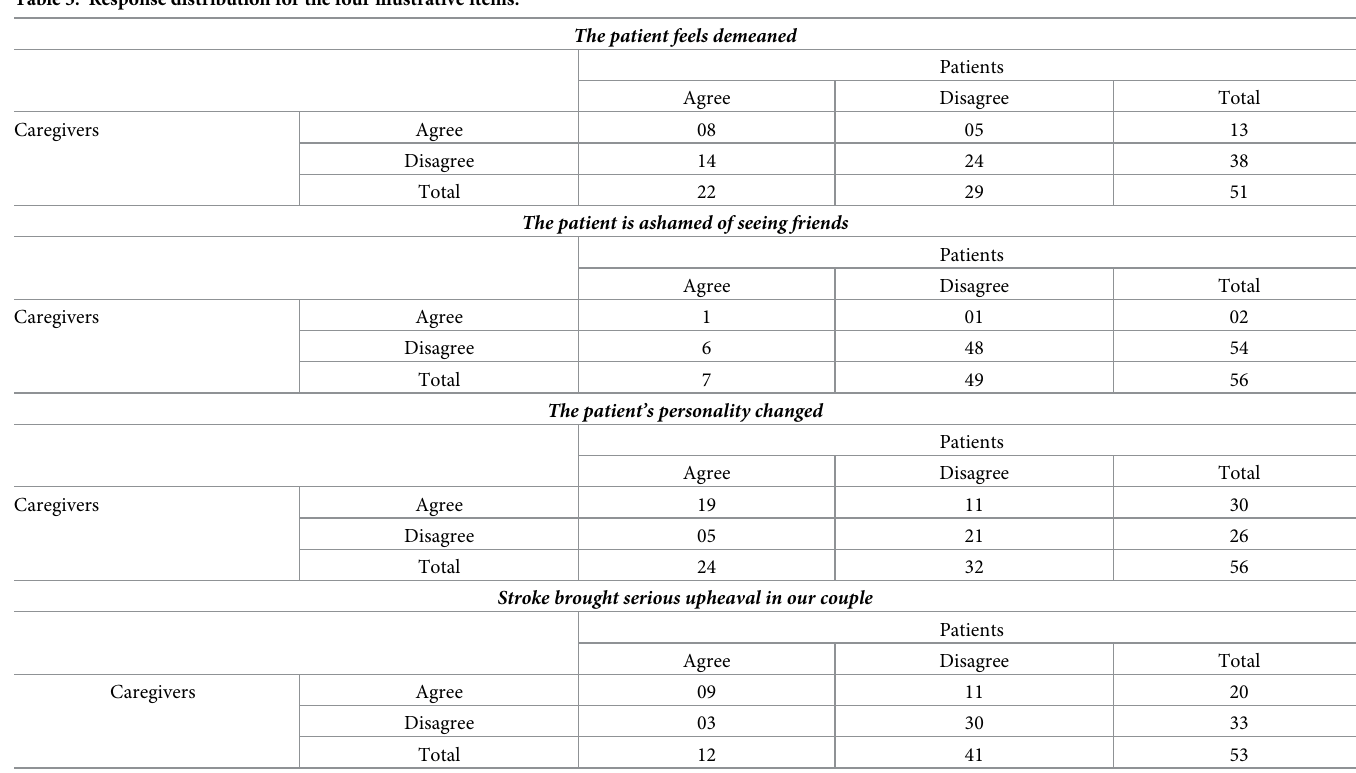
Table 3. Response distribution for the four illustrative